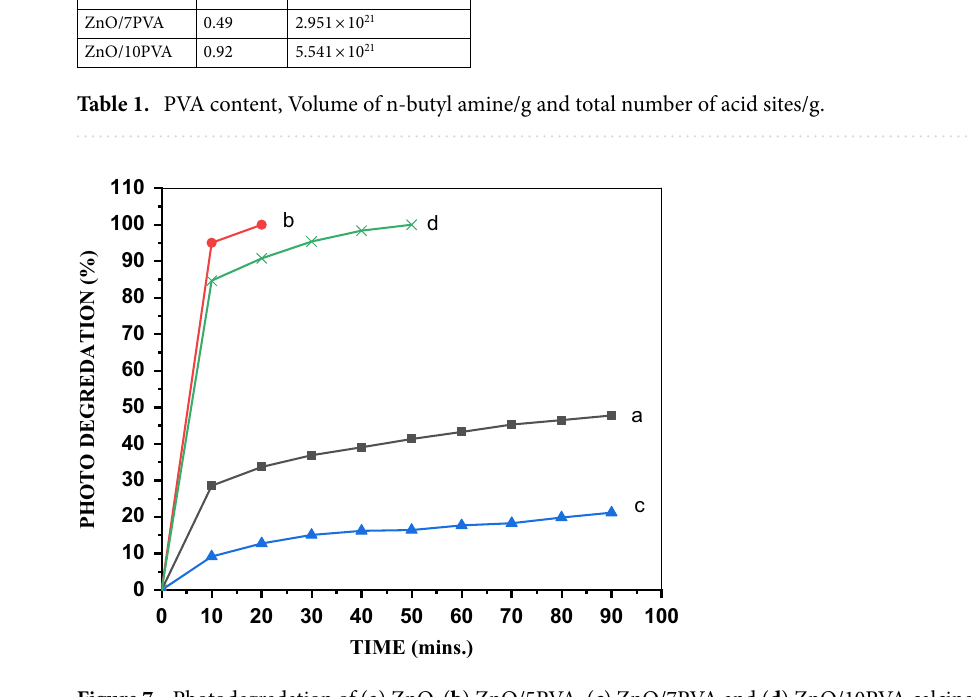
Figure 7. Photodegredation of ( a ) ZnO, ( b ) ZnO/5PVA, ( c ) ZnO/7PVA and ( d ) ZnO/10PVA calcined at 300 °C of MB.